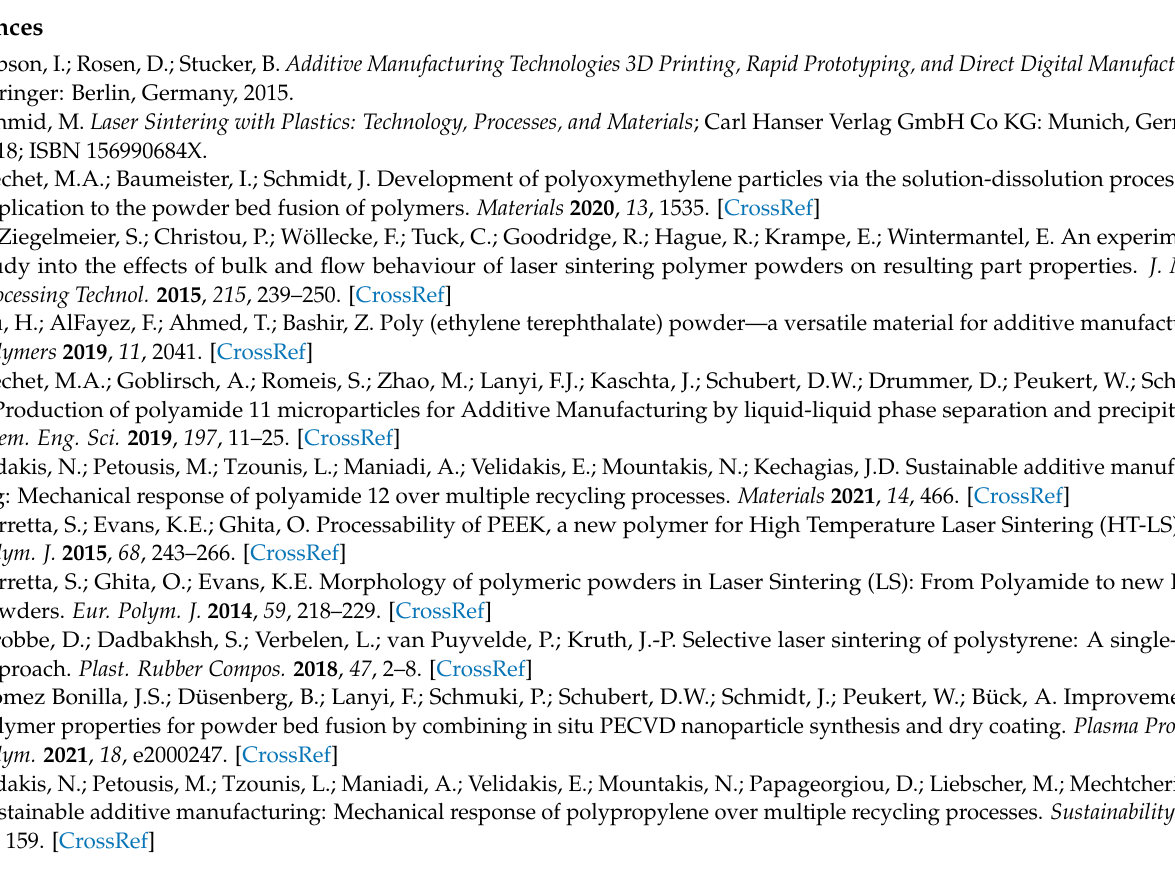
transfer roll; Figure S1: Crystallization behaviour of the functionalized powders; left: Crystallization enthalpy; right: Crystallization temperature; n = 3. The corresponding values are displayed in Table